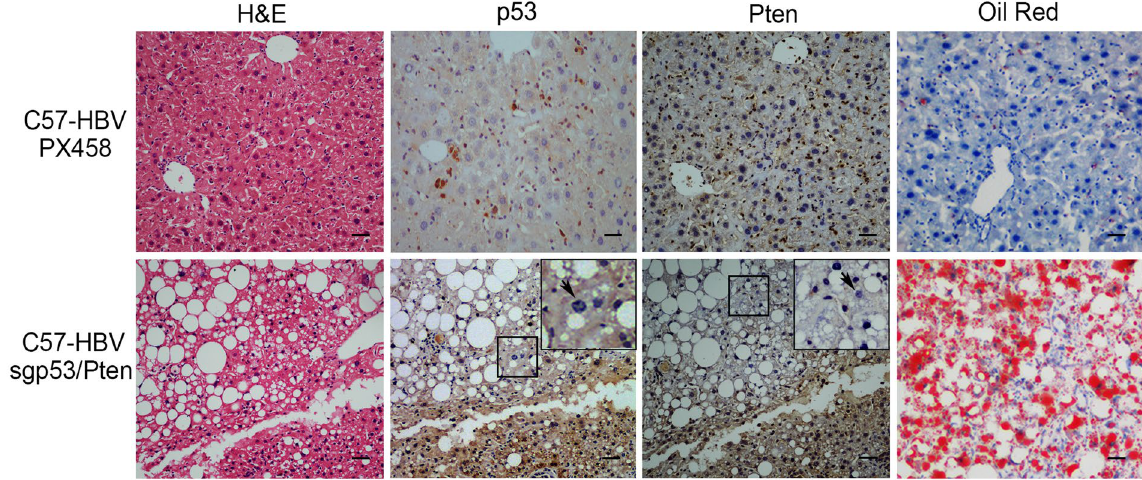
Figure 6. IHC assay of somatic dysfunction in liver tissues of HBV transgenic mice. Liver sections from C57-HBV mice injected with sgp53/Pten or PX458 (as a control) were strained by H&E, p53, Pten and Oil Red Staining The insets are high-magnification views (X400). The arrows in p53 and Pten IHC indicated the negative stained hepatocyte. The scale bar is 100 μ